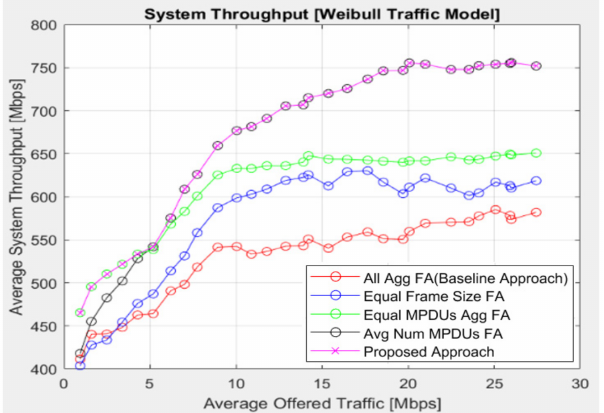
Figure 8. Performance of average system throughput with increasing offered traffic load using the Weibull traffic model.